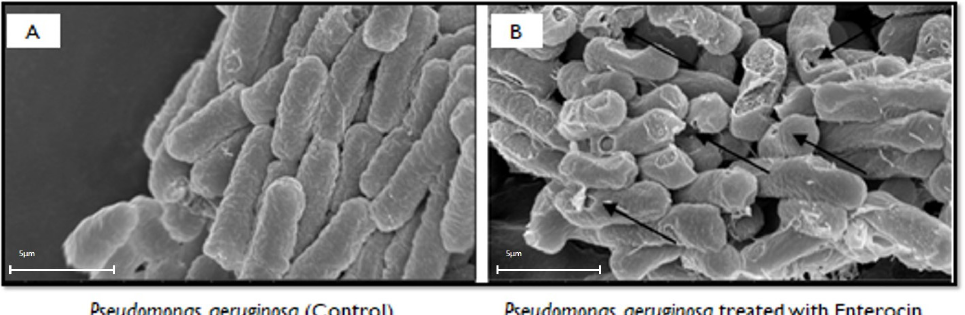
Figure 6. Mode of action of enterocin KAE 01 using SEM; P. aeruginosa ( A ) control and ( B ) treated. Arrows point toward cells that have ruptured due to antimicrobial effect of enterocin (Scale: 3 kV; X60000).